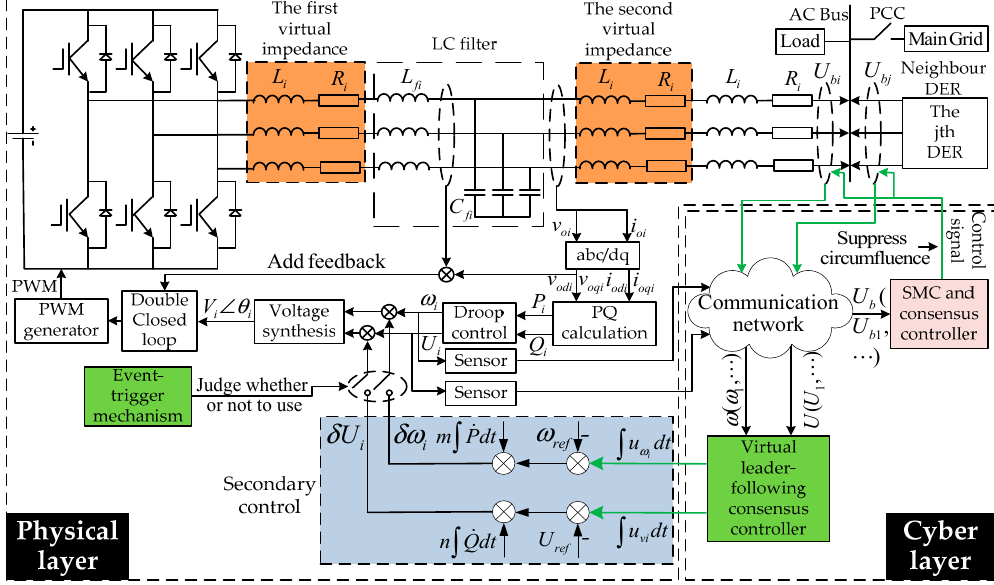
Figure 1. The hierarchical control structure of the i -th distributed energy resource (DER). AC: alternating current; LC-filter: inductance capacitance filter (i.e., passive filter); PCC: point of common coupling; PQ: active power and reactive power; PWM: pulse-width modulation.